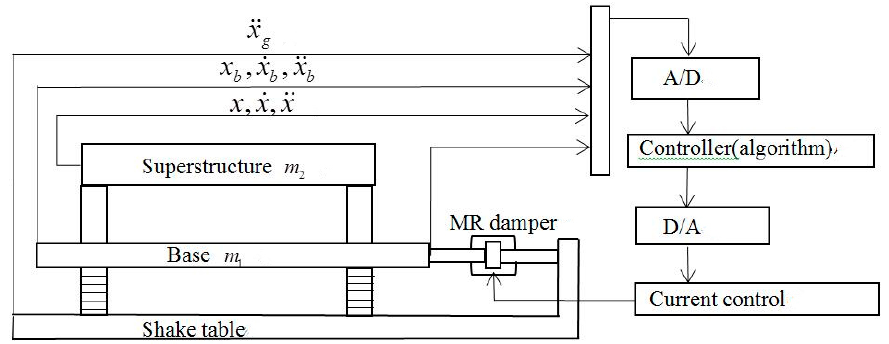
Figure 1. Sketch of structure and control system.